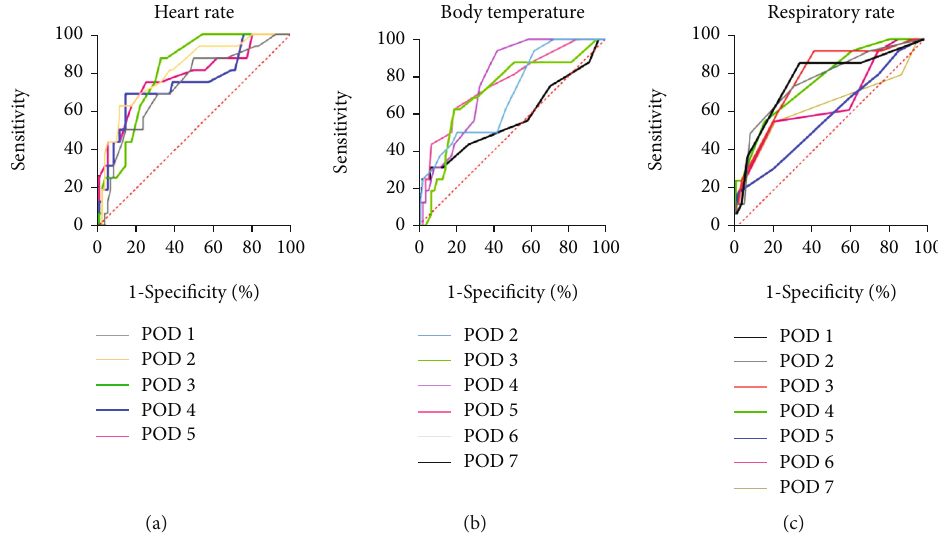
Figure 2: ROC curve analysis for heart rate (a), body temperature (b), and respiratory rate